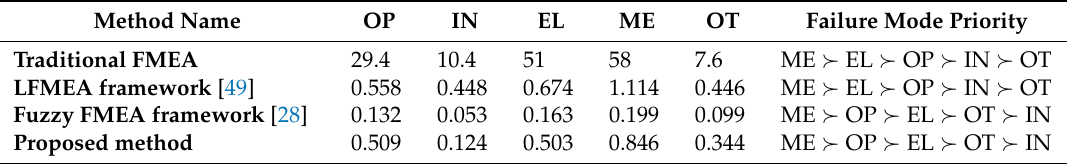
Table 14. Final risk priority number with FMEA method ranking